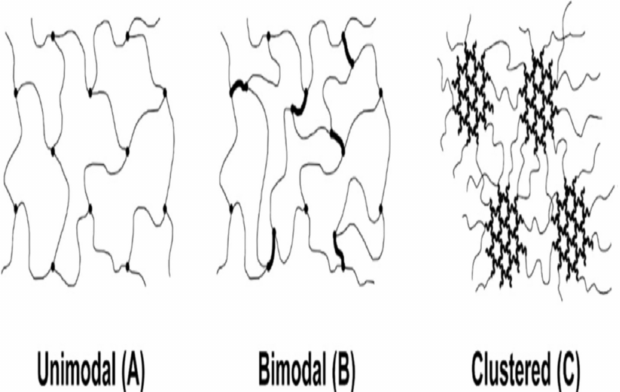
Figure 1. Schematics of unimodal, bimodal, and clustered crosslinked PEO networks. Adapted from [27].